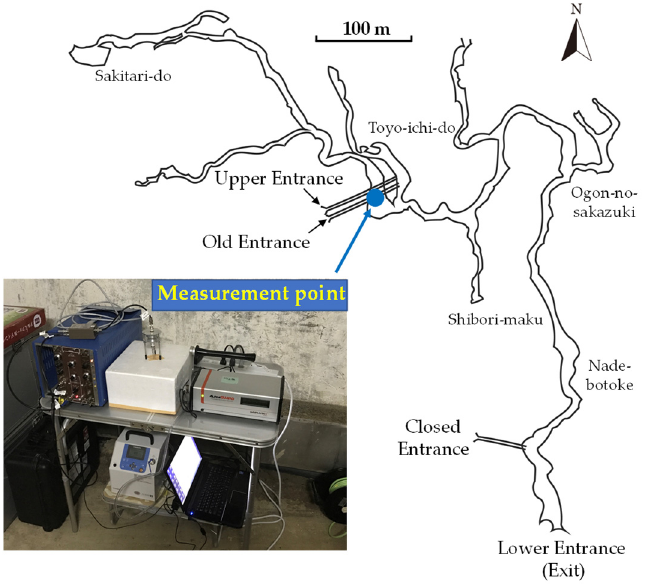
Figure 2. Map of Gyokusen-do Cave showing the measuring point and a photo of the measurement setup (This map was drawn using reference [23]).